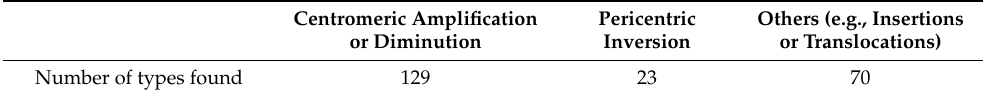
Table 3. Number of different types of human heterochromatic chromosomal heteromorphisms (CHs) found in all chromosomes according to [53].